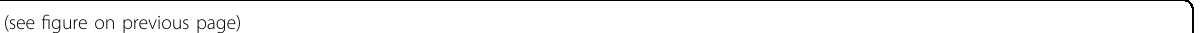
Fig. 5 Decreased protein synthesis by ATP depletion and the short half-life reduced the level of cdc20 during mitotic slippage. a Mitotic arrested cells were treated with 2-DG and NaN 3 (2 + N), and expression of Cdc20 mRNA was analyzed by real-time PCR. The results are given as the mean ± SD from three independent experiments. b Experimental design (upper panel). For protein synthesis experiments, HeLa cells grown in DMEM/high glucose were used. Cells arrested in mitosis were obtained by nocodazole treatment (100 ng/ml) for 15 h followed by shake-off, and then were incubated in methionine-free medium with nocodazole. After 1 h, cells were pre-exposed to 2-DG and NaN 3 (2 + N) for 30 min. [ 35 S]- methionine was added to the medium, and proteins were labeled for 2 h and subsequently chased by the addition of an excess of unlabeled methionine for 1 h, 2 h and 4 h. Total cell lysates and immunoprecipitated lysates using Cdc20 or Cdh1 antibody were resolved by SDS-PAGE and visualized by Coomassie Blue staining or autoradiography. c Mitotic arrested cell lysates from the indicated times after co-treatment with 2-DG and NaN 3 (2 + N) were subjected to western blot analysis using antibodies for Cdc20, phospho-p70S6 kinase, and GAPDH. d Quanti fi cation of the relative intensity of Cdc20 or Cdh1 was performed by measuring the band intensity using ImageJ software. e For inhibition of protein synthesis, cells were treated with 10 μ g/ml cycloheximide for 30 min prior to co-treatment with 2-DG and NaN 3 . Cell lysates from the indicated times after co-treatment with 2-DG and NaN the relative intensity of Cdc20 or Cdh1 was performed by measuring the band intensity using ImageJ software (lower